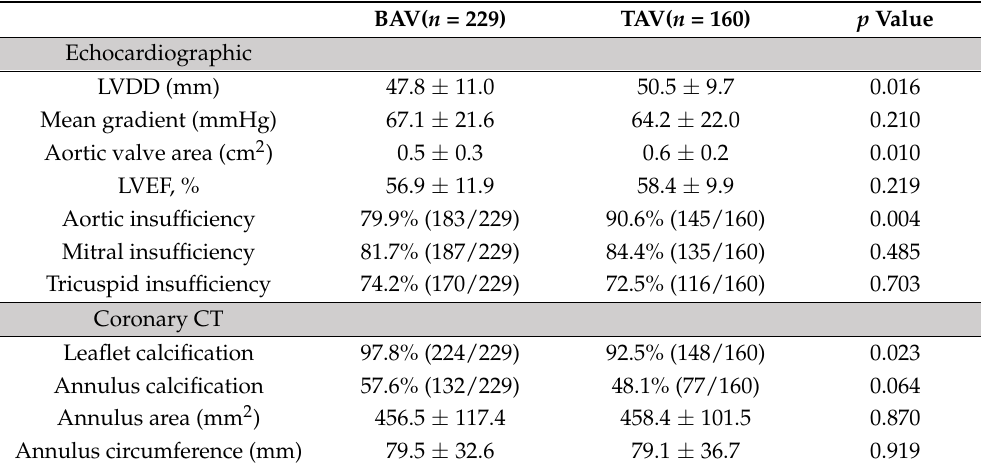
Table 2. Pre-Procedural Imaging Analysis.